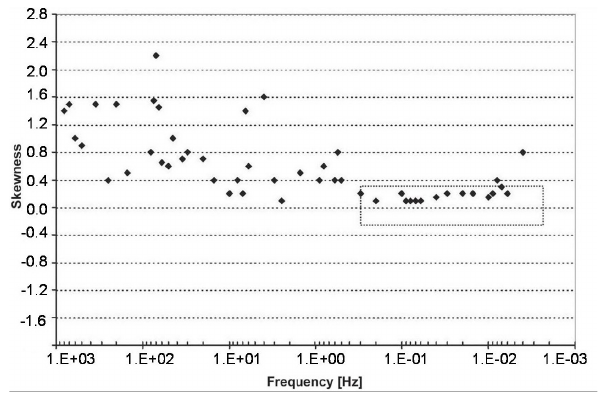
Fig. 3. Skew coefficient versus frequency; values less then 0.3 (in rectangle) indicate the frequency range where there is a 2-D struc-